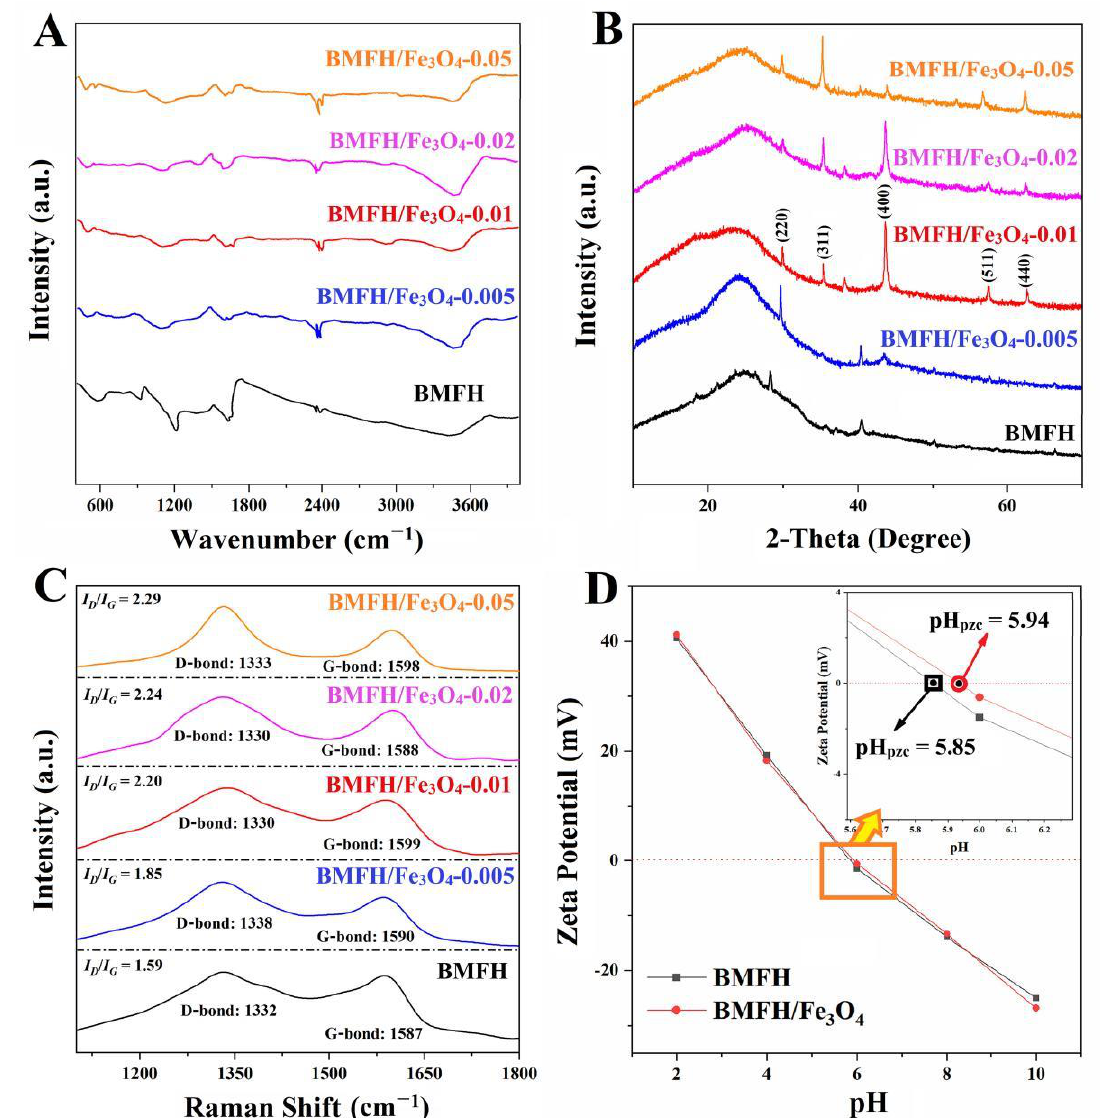
Figure 3. ( A ) FT-IR spectra, ( B ) XRD pattern, ( C ) Raman spectra of samples, and ( D ) Zeta potential tests of BMFH/Fe 3 O 4 -0.01.